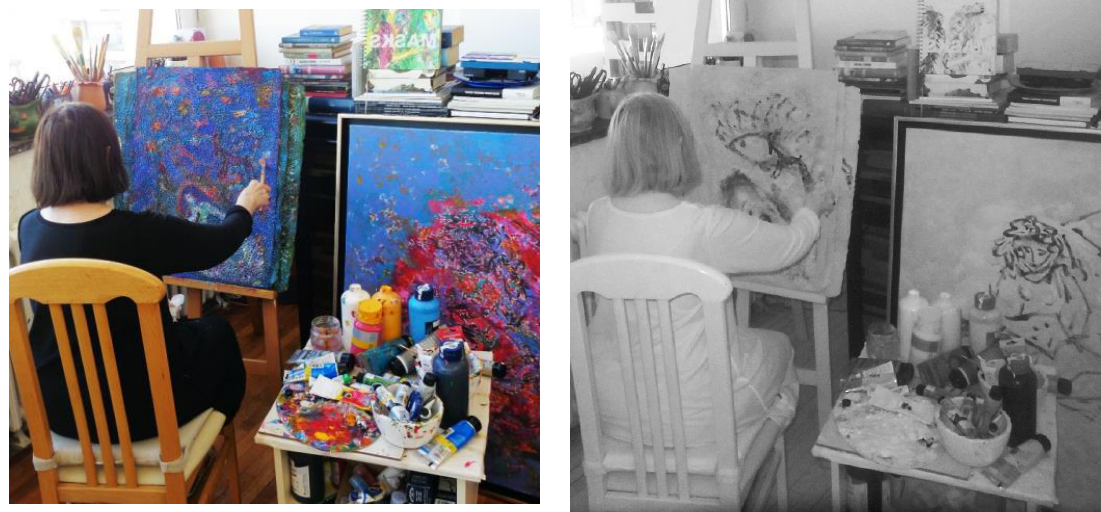
Figure 7. Atelier in visible and NIR spectra (IRR—ZRGB cameras).